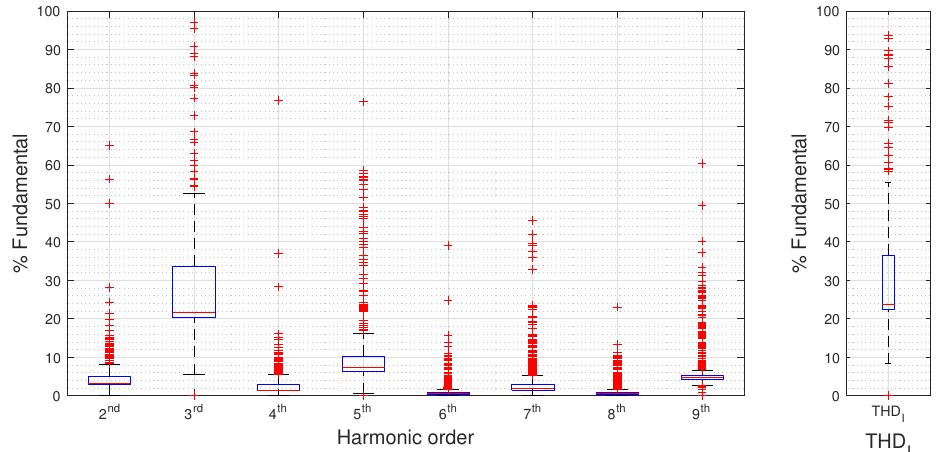
Figure 7. Current harmonics and the THD I of the measured charging